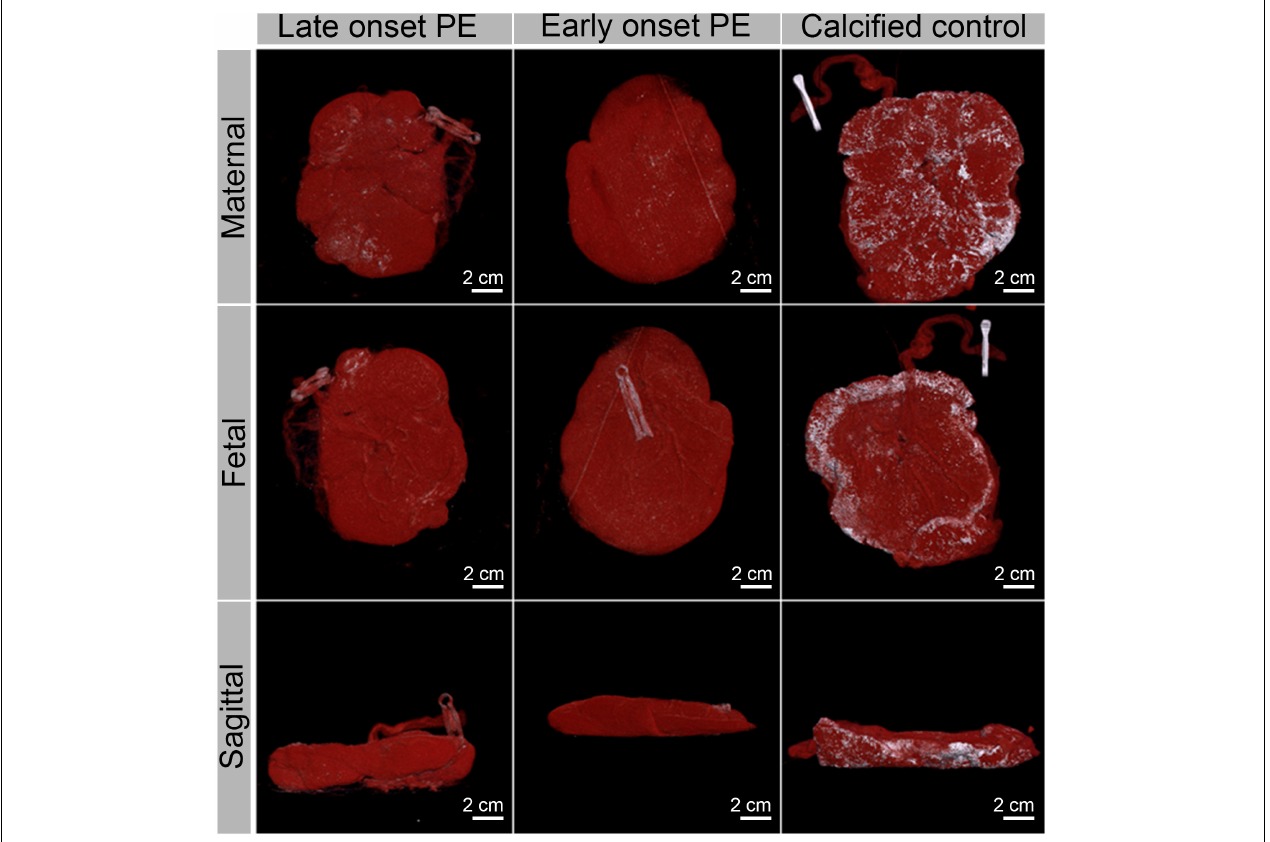
FIGURE 3 | Computed tomography images of three representative placentae (a late onset PE placenta, an early onset PE placenta and a calcified control placenta, see Table 2 for their characteristics) in maternal, fetal and sagittal view. Soft tissue is shown in red while calcifications appear in